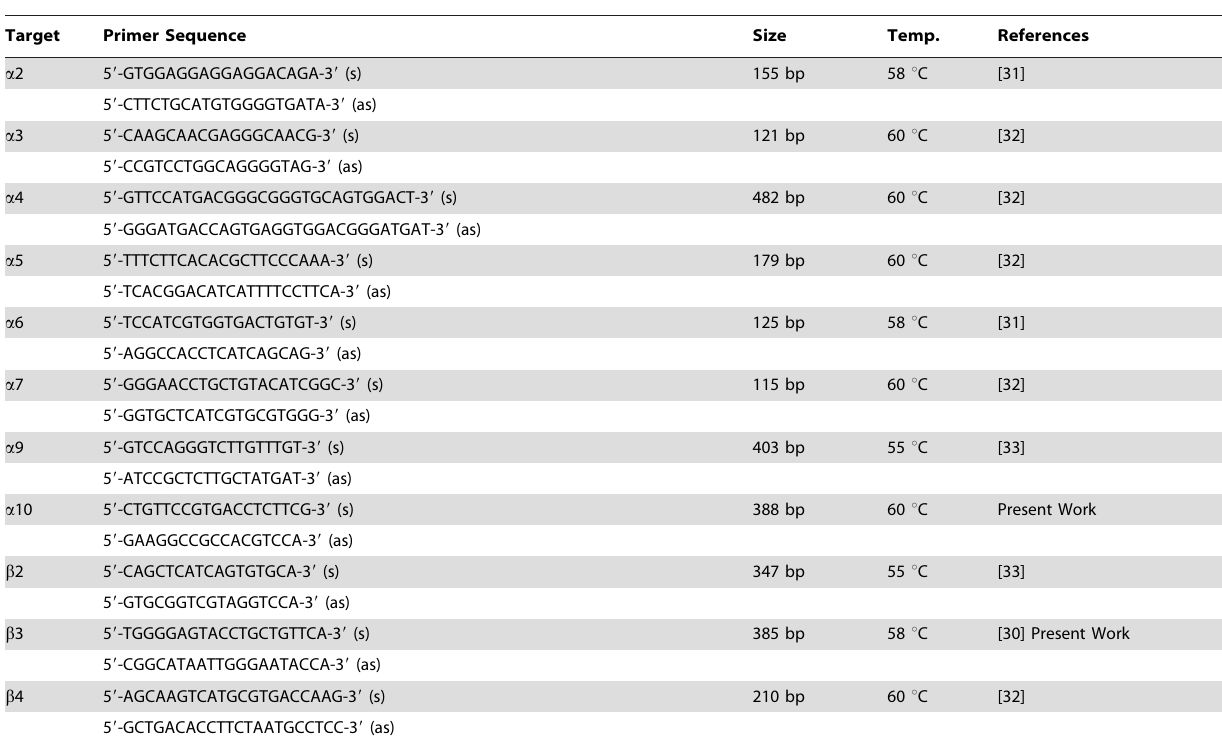
Table 1. PCR primers.